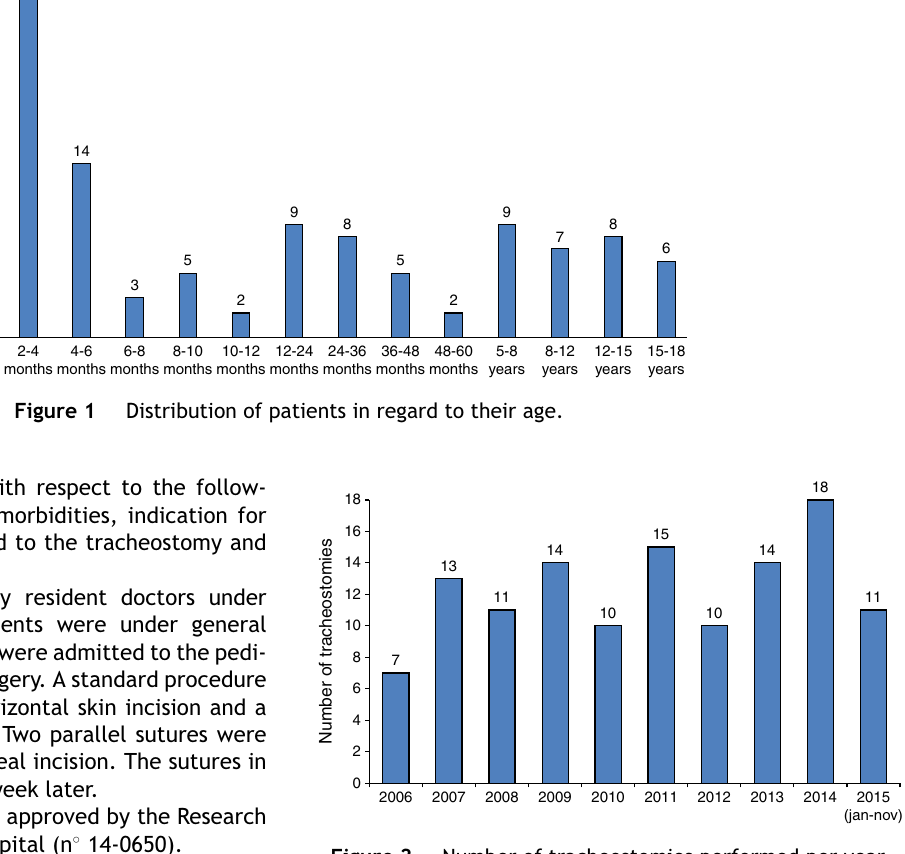
Figure 2 Number of tracheostomies performed per